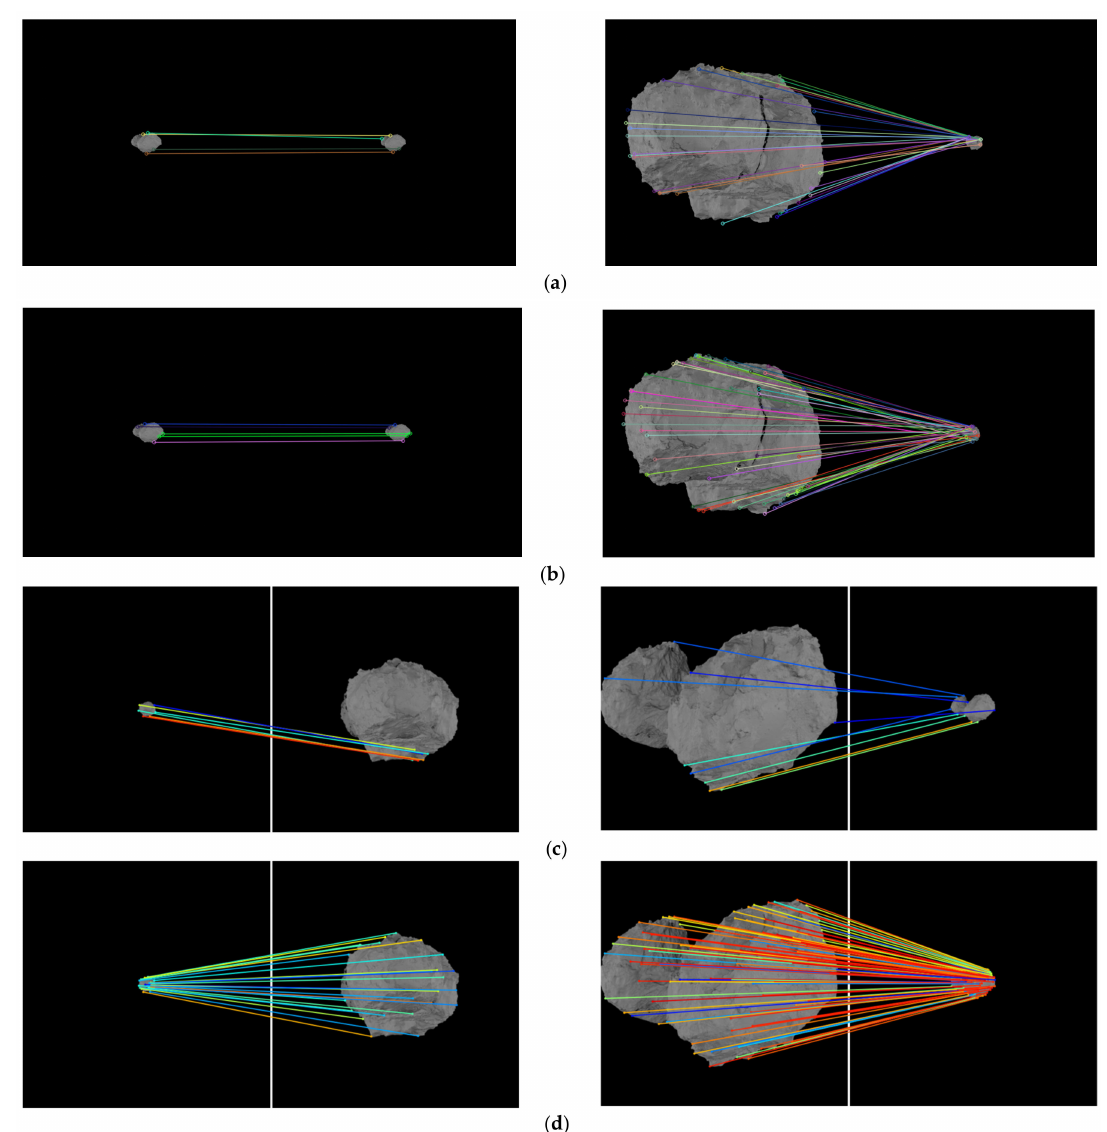
Figure 10. Image matching visualization results in the virtual SCB dataset. ( a ) SIFT + FLANN, ( b ) SIFT + FLANN + DeepSpace-ScaleNet, ( c ) SuperPoint + SuperGlue, ( d ) SuperPoint + SuperGlue +